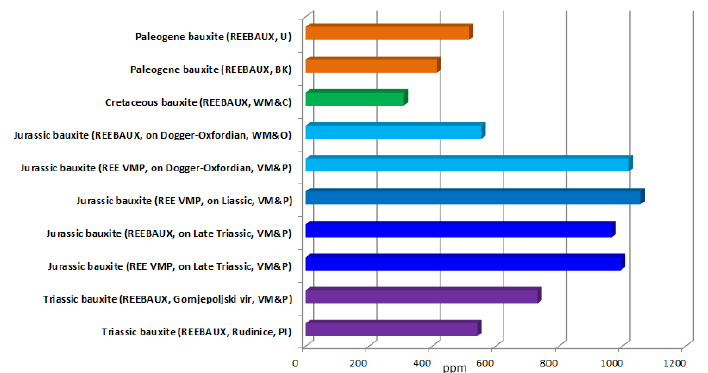
Figure 15. Content of Σ REE in the studied bauxite formations in Montenegro, (after Radusinovi ć [5]; REEBAUX [6]), (ppm).